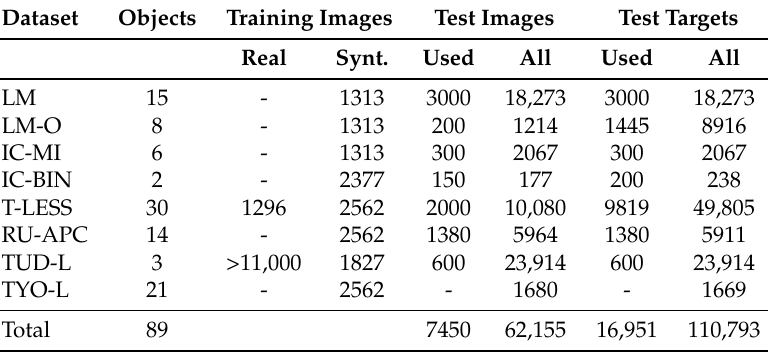
Table 1. BOP benchmark dataset [29]. Each dataset has several objects, training images and test images. Some test images have more than one object, defining several test targets. Used values represents the current subsets used for the methods